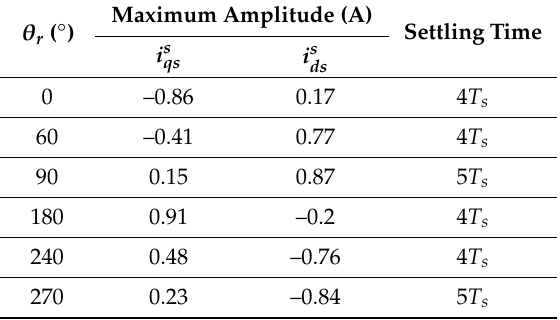
Table 2. Measured currents at various positions when the restarting strategy is implemented.